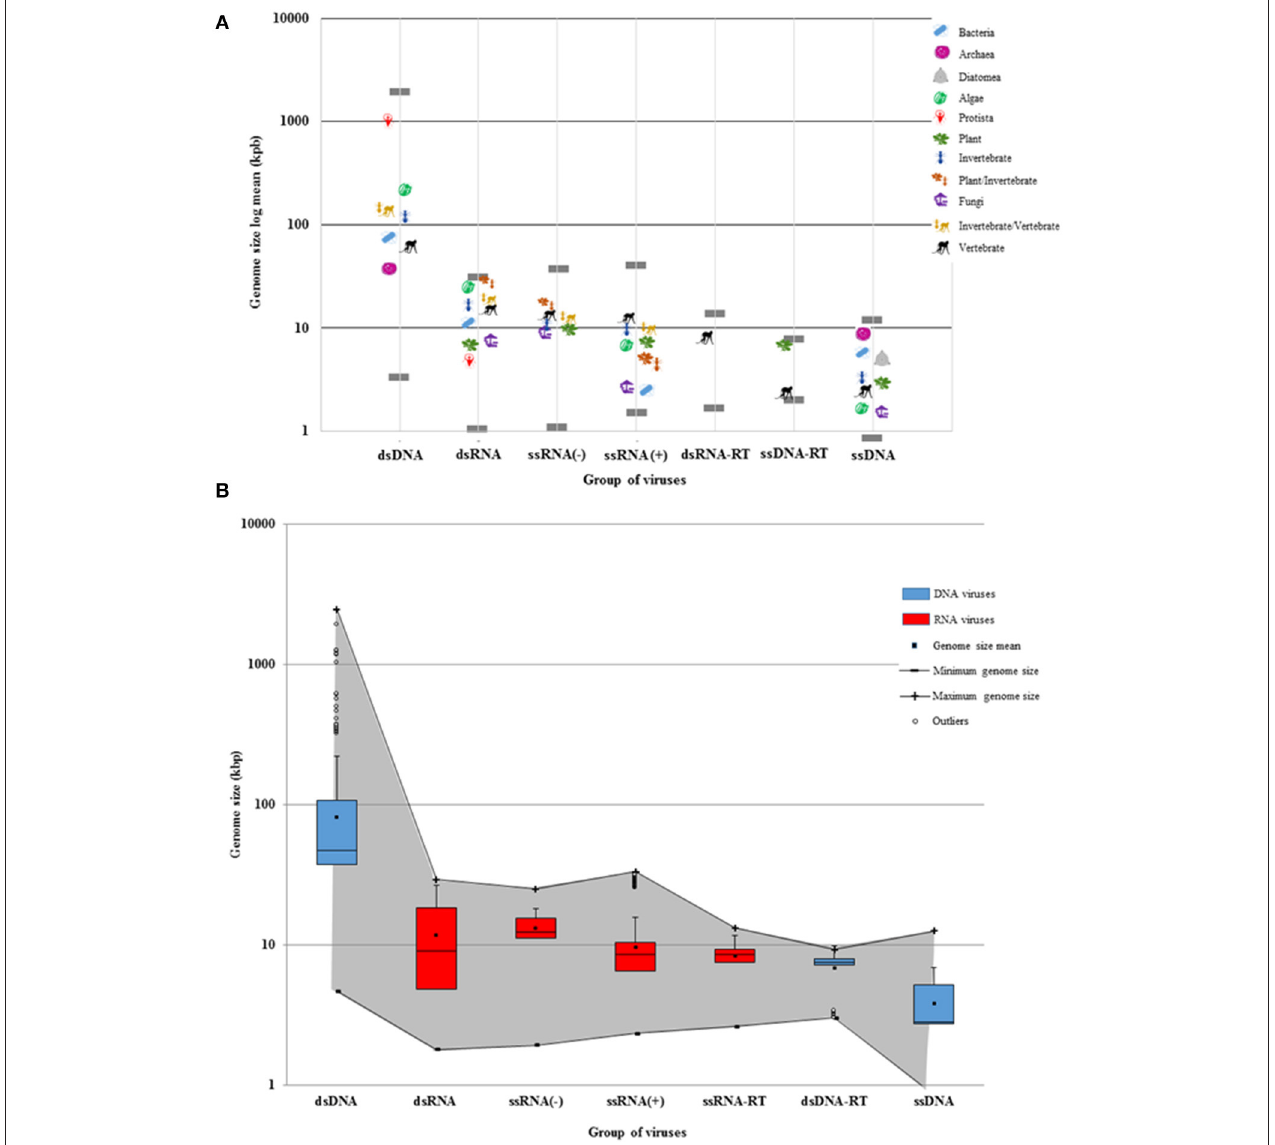
FIGURE 2 | Viral genome sizes and the Baltimore groups. (A) The genome size average of viruses was calculated according to each Baltimore group and host type. Each host is denoted by a representative organism. Gray lines show the largest and the smallest virus of each Baltimore group. DNA viruses are grouped into two size extremes of the log graph (dsDNA and ssDNA). The dsDNA virus genomes show a more extended diversity than ssDNA genomes. Bacteria hosts can also be infected by longer dsDNA viruses, but rarely by RNA viruses. RNA and ssDNA viruses display more restricted genomes. However, RNA virus genomes can be larger than ssDNA genomes. The largest and the smallest RNA viruses are found as parasites infecting eukaryotes. Some families of RNA viruses can infect phylogenetically-distant hosts (plants and invertebrates, or invertebrates and vertebrates). Retroviruses only infect plants and vertebrates. (B) The maximum and minimum genome size of RNA (red) and DNA (blue) viruses are denoted by a gray shadow. While DNA viruses have a more-delineated plasticity of genome size, RNA viruses have more restricted genomes. There are more ds-and-ss DNA viral species that tend to have larger genomes as shown in the third quartile. While ssDNA and ds-RT DNA viruses have as restricted genomes as RNA viruses, dsDNA viruses tend to have larger genomes as shown in the outliers. The mean, the median, and the standard deviation were calculated from the 4182 viral reference strains of